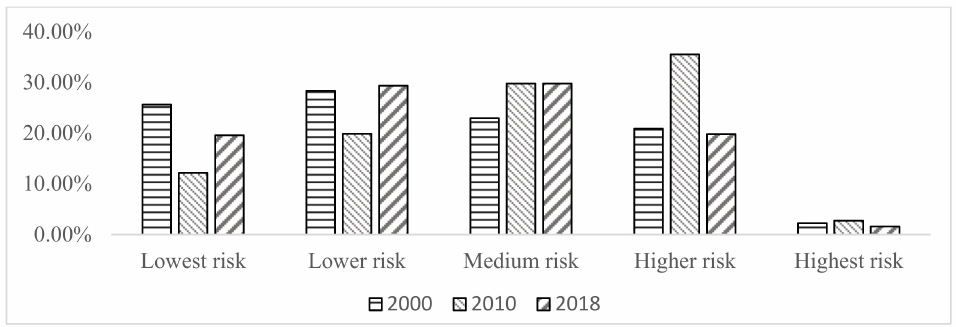
Figure 5. Proportion of different landscape ecological risk area of Chaoyang